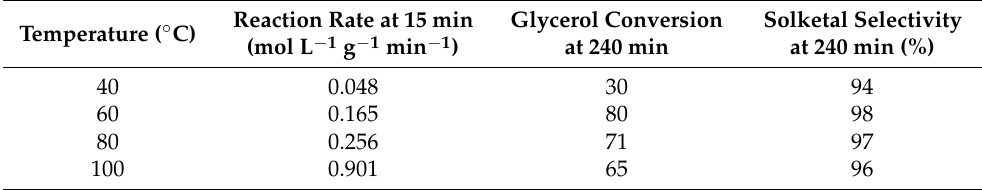
Table 4. Reaction tests for solid CBA at different temperatures. Reaction conditions: p = 2 MPa,